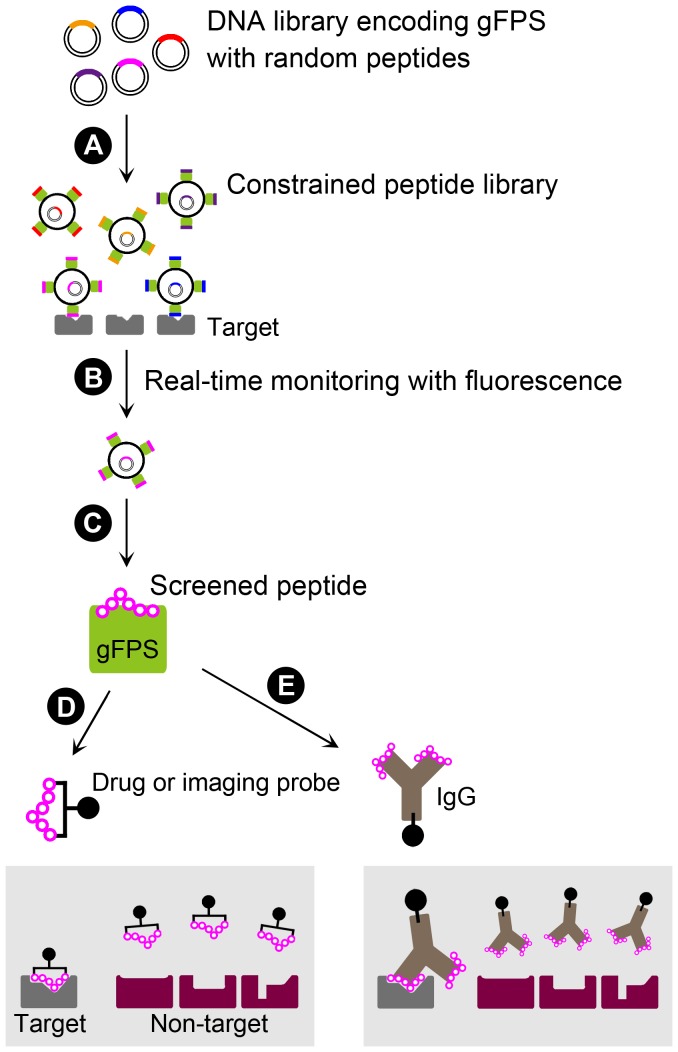
A one-step peptide screening system using gFPS.DNA libraries encoding gFPS with random peptides are introduced into the host (e.g., phage, bacteria, yeast, mammalian cells), resulting in the display of structurally constrained peptides on the host cell surface (A). The host cells that express peptides that bind to the target are easily selected based on gFPS fluorescence (B). The plasmid in the selected host is amplified and the DNA sequence of the corresponding peptide is determined (C). The identified peptides can be tested in vivo using structurally constrained forms such as circularized peptides (D) or following integration into in vivo scaffolds such as immunoglobulin G (IgG) molecules (E). These peptides retain unique structures that specifically bind to the target molecule with high affinity in vivo.